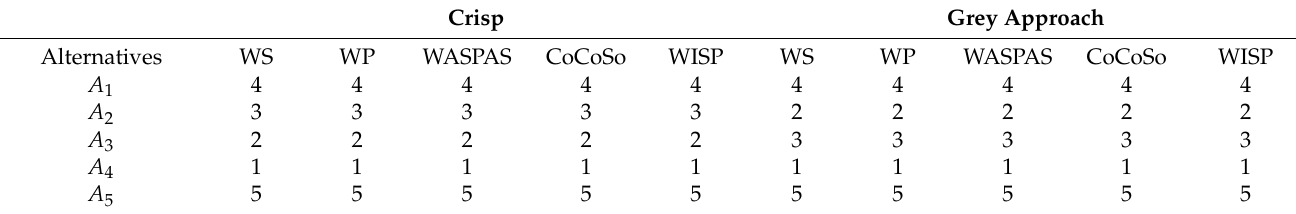
Table 17. Ranking orders of alternatives obtained on the basis of 100 virtual